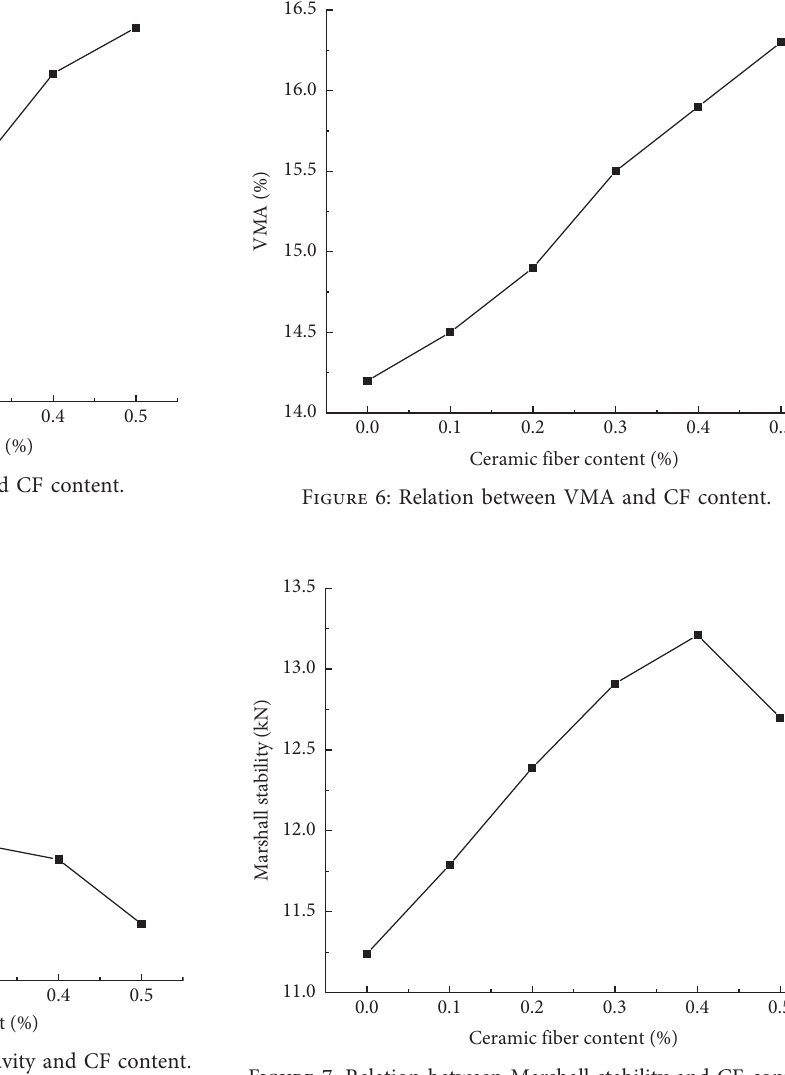
Figure 7: Relation between Marshall stability and CF content.